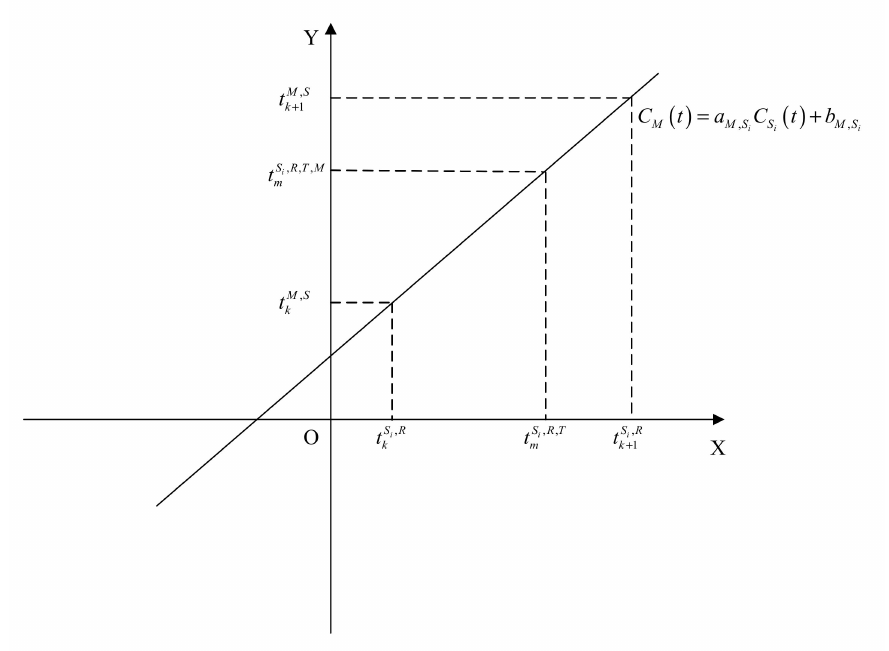
Figure 2. Coordinate graph of the relationship between the master base station clock ( Y axis) and the slave base station clock ( X